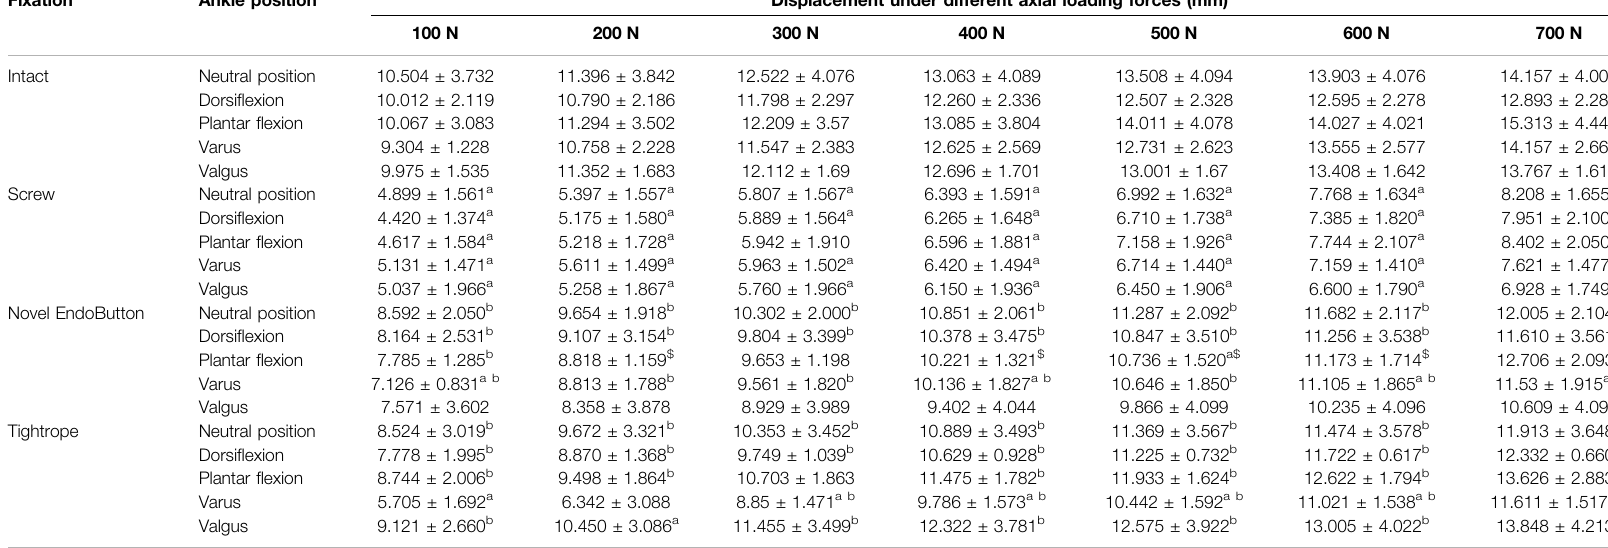
TABLE 1 | Displacement in different ankle positions.